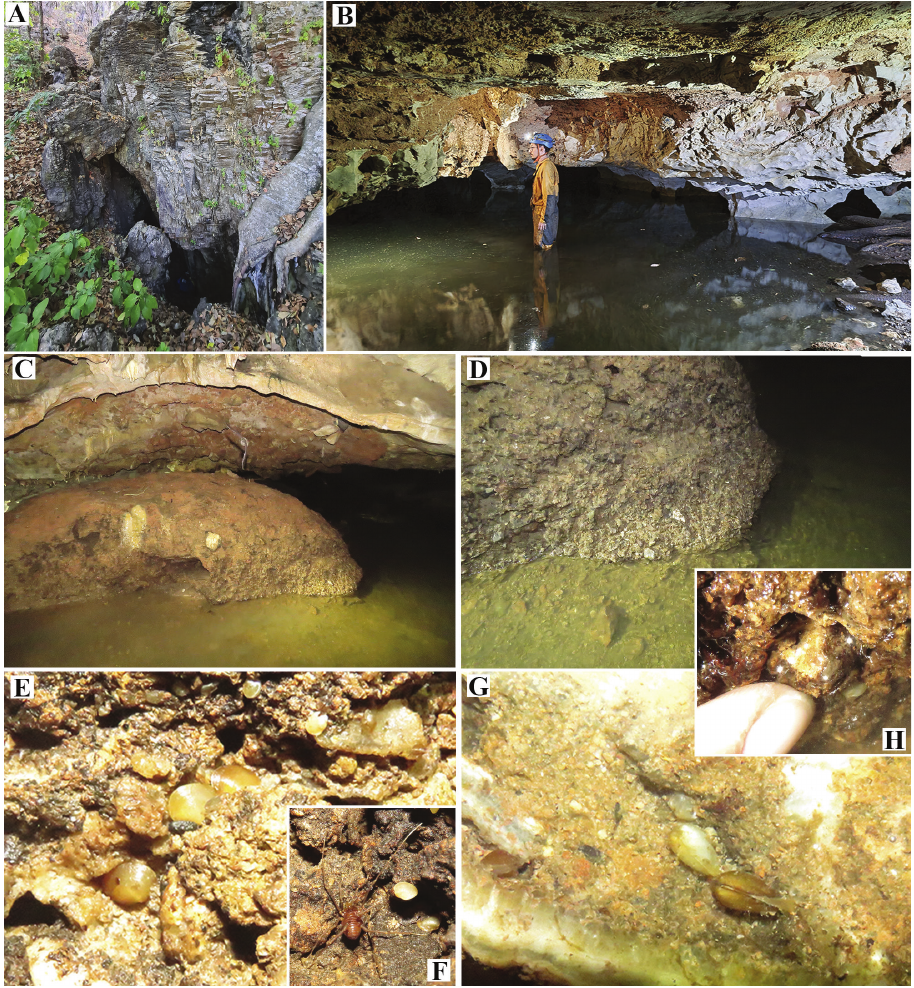
Figure 35. Casa de Pedra cave A secondary upper entrance of the cave B cave chamber that was par- tially flooded C area inside the cave where specimens of E. troglobia sp. nov. were found D detail of the consolidated sediment indicating the area where submerged specimens of E. troglobia sp. nov. were found E E. troglobia sp. nov. specimens in situ exposed to the air F same, detail of an air exposed specimen, with a harvestman ( Eusarcus sp.) near it G in situ submerged specimens of E. troglobia sp. nov. H location of a submerged specimen of E. troglobia sp.